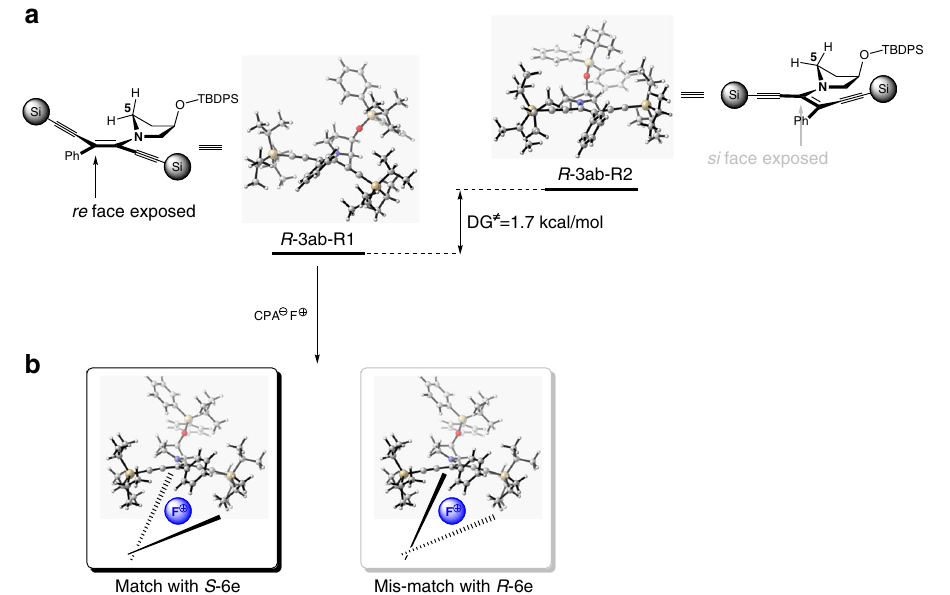
Fig. 3 Simpli fi ed proposal for the stereoselectivity. a Minimized conformation of R -3ab-R1 and R -3ab-R2 is represented in ORTEP diagrams; the facial selectivity is likely controlled by the adjacent methylene group (C5); Si = TIPS; b the CPA anion is simpli fi ed as “ chopsticks ” for clarity